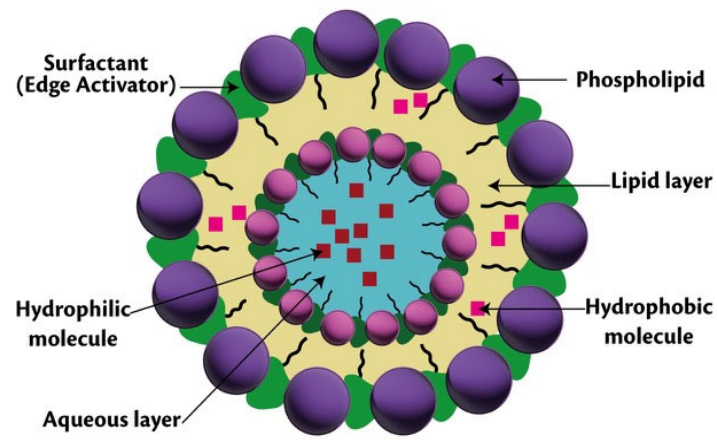
Figure 3. The basic structural components of the deformable transfersome.